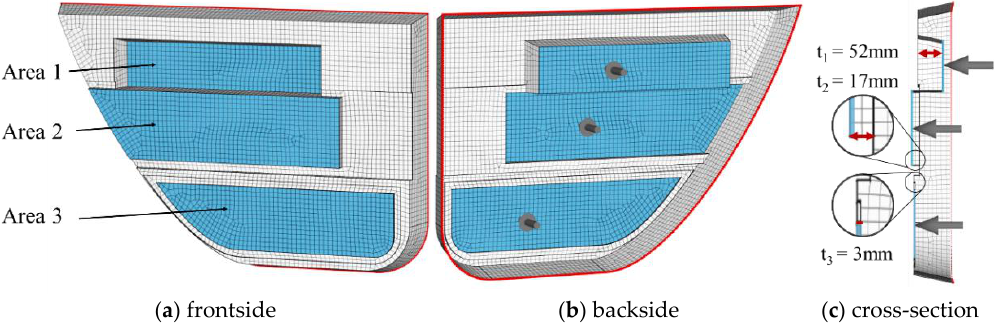
Figure 2. FE simulation model based on a CAD model meshed with CQUAD8 Elements and with fixed constraints on the free edges; ( a ) the frontside of the panel, ( b ) the backside with individual point forces, and ( c ) the cross-section with individual structure depths marked red.